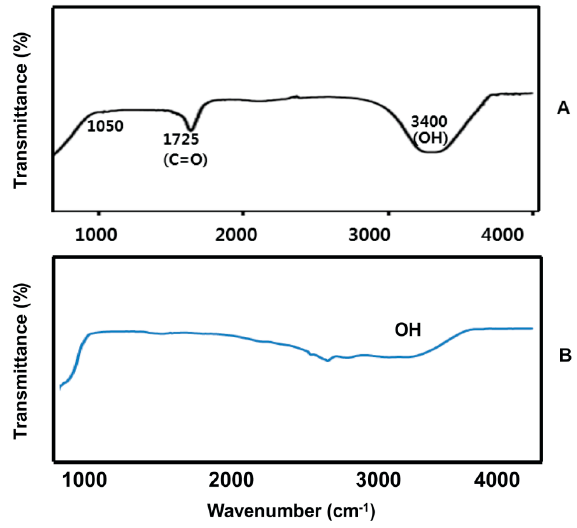
Figure 3. FTIR spectra of GO ( A ) and UA-rGO ( B ). FTIR spectrum of the UA-rGO shows significant reduction of nearly all of the oxygen-containing functional groups, especially the carboxylic acid groups and epoxide bonds.